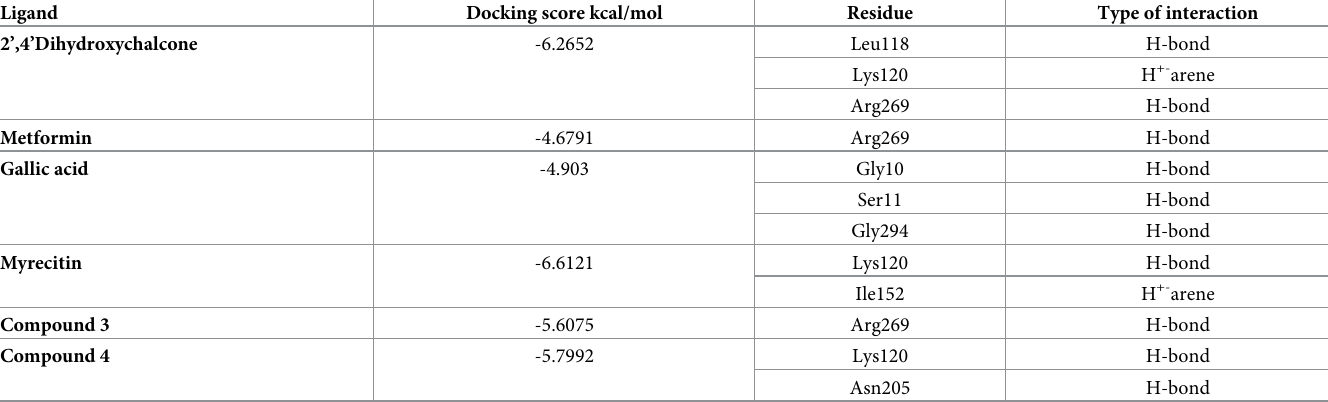
Table 6. Molecular docking results and ligand inteactions of major phytoconstituents of Limonium axillare root extract in active site of glycerol-3-phosphate in comparison with known inhibitors. Ligand